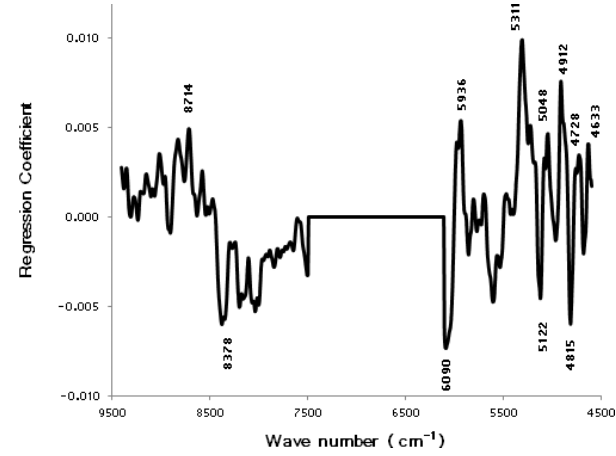
Fig. 3. Regression coe±cient plot of gamma oryzanol content of MGBR-various varieties.